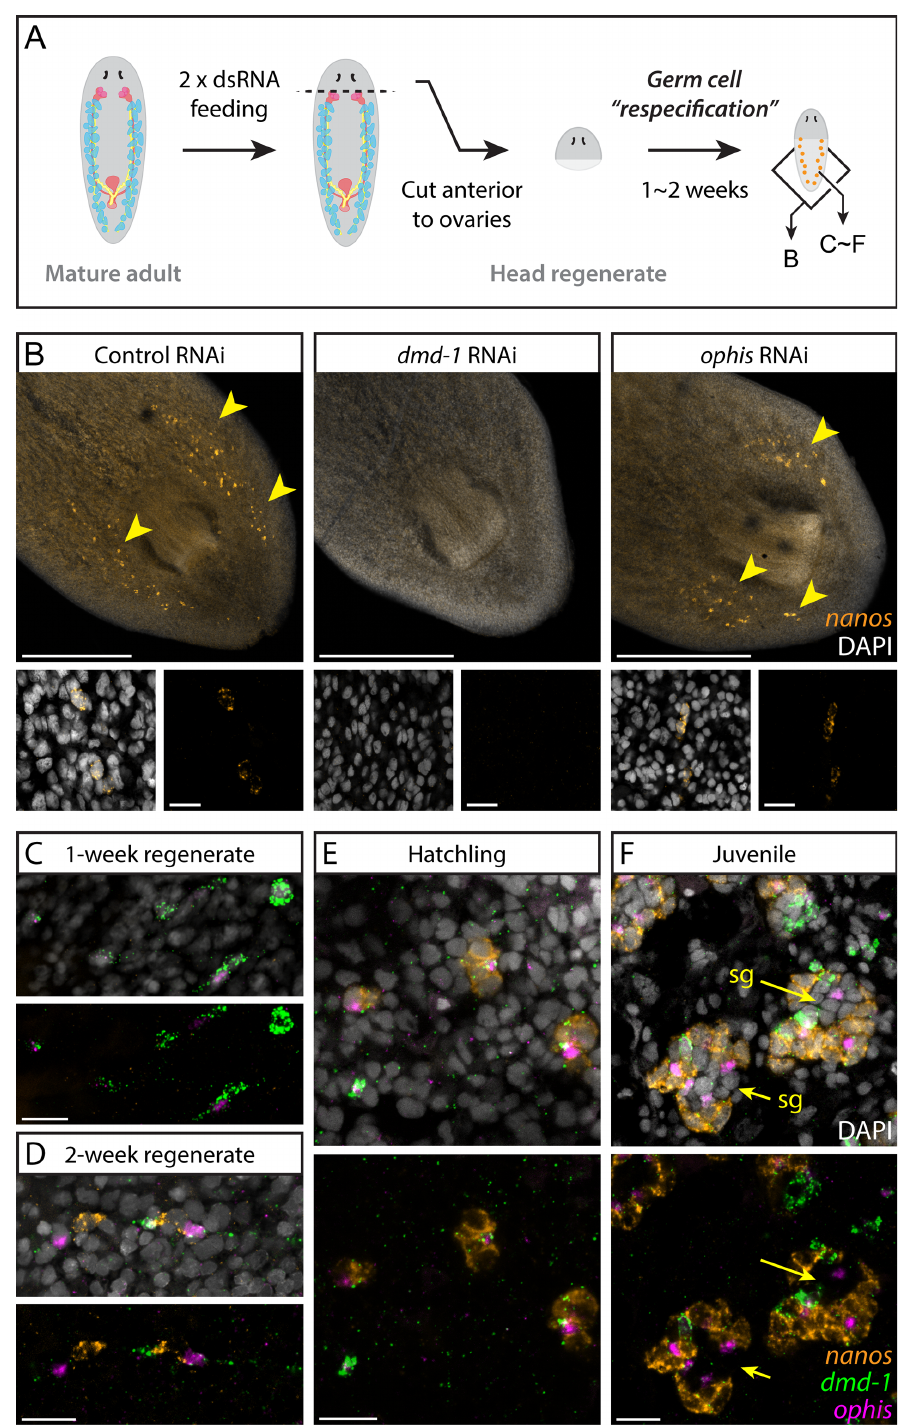
Fig 7. Somatic dmd-1 + /ophis + cells facilitate testis regeneration and development in planarians. (A) Germ cell re-specification paradigm used to challenge worms to specify a germline de novo. Indicated genes were knocked down in worms prior to amputation. After 1 to 2 wk of posterior regeneration, regenerates were fixed and labeled to detect nanos expression. Schematic shows areas imaged in panel B and panels C – F. (B) FISH labels nanos + GSCs in 2-wk head regenerates of control, dmd-1(RNAi) , and ophis(RNAi) planarians. Unlike dmd-1 , ophis is not required for de novo germ cell specification during regeneration of